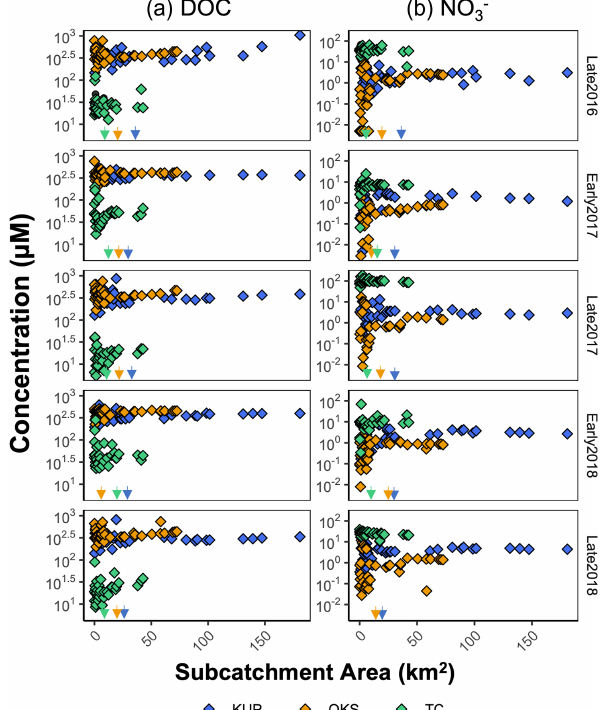
Figure 10. Scatter plot of log-scale (a) DOC and (b) NO 3 − con- centrations (µM) across subcatchment area (km 2 ) or each repeated sampling in the Kuparuk River (blue points), Oksrukuyik Creek (or- ange points), and Trevor Creek (green points) watersheds. Signifi- cant variance collapse thresholds are represented by a colored ar- row.